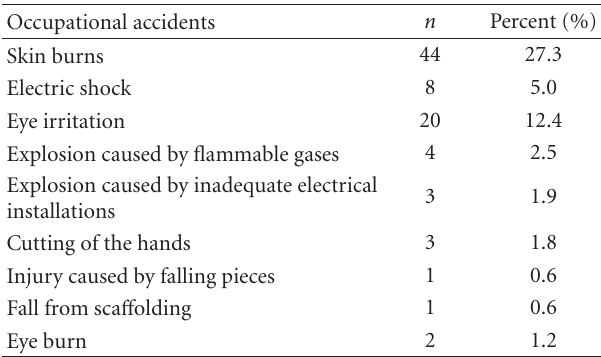
Table 3: Occupational accidents reported by apprentice welders ( n =